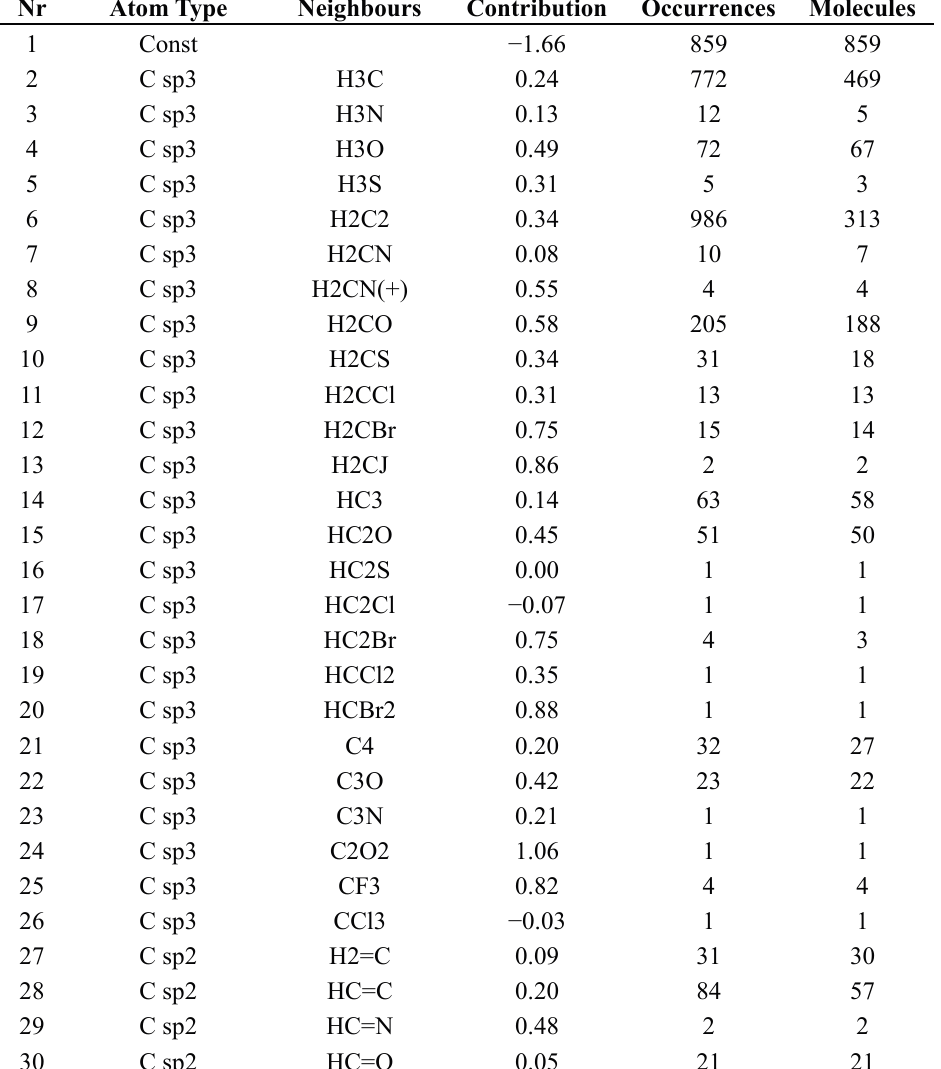
Table 15. Atom group Contributions for Toxicity